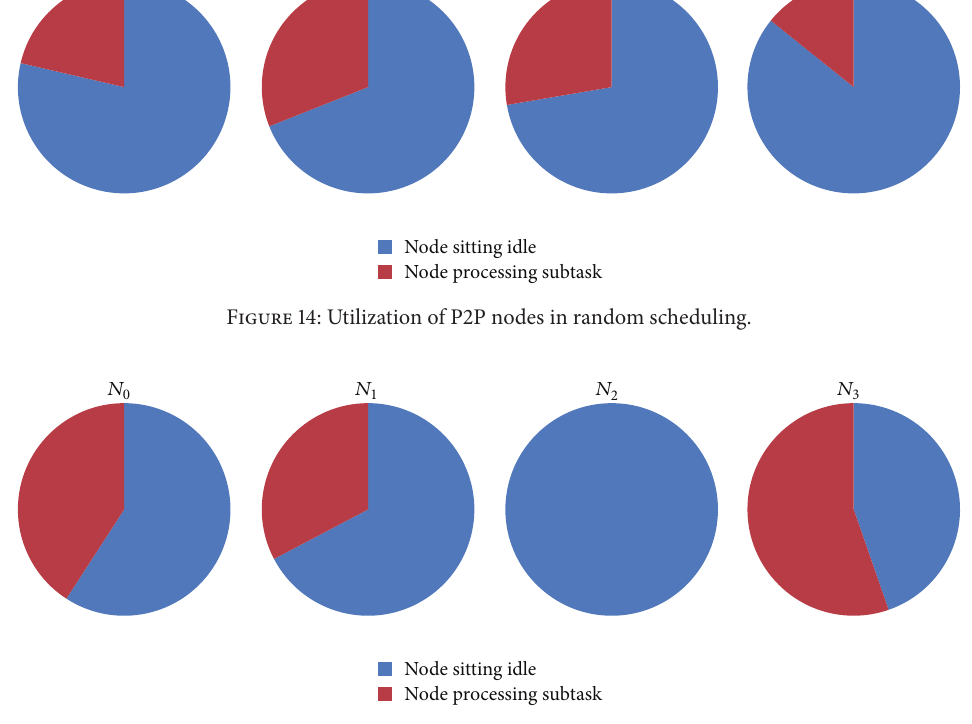
Figure 15: Utilization of P2P nodes in old